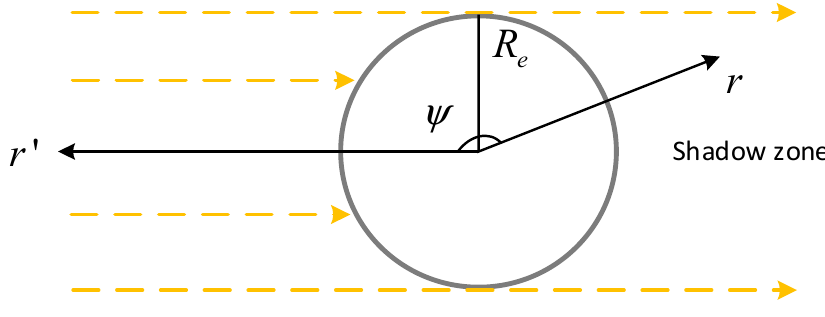
Figure 3. Cylindrical shadow model.